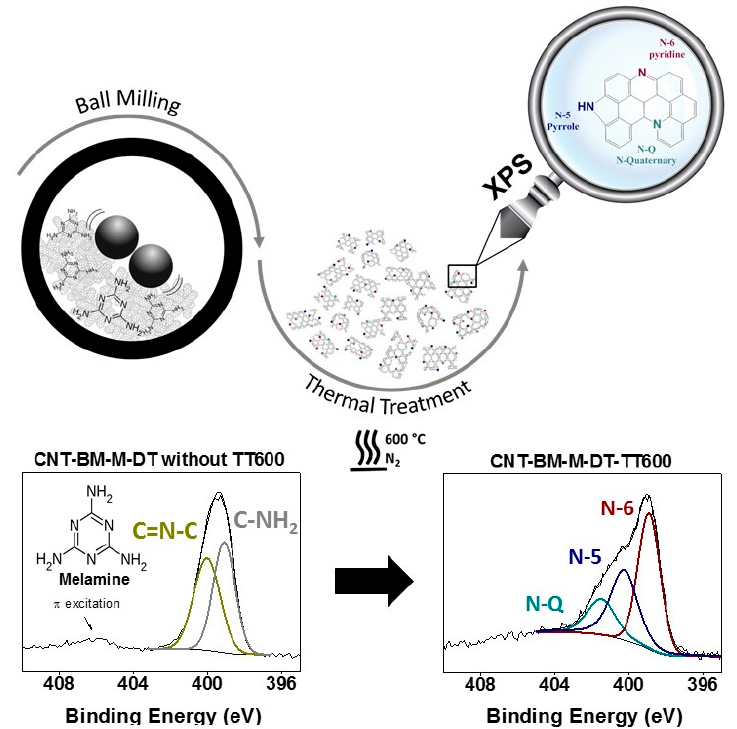
Figure 5. Illustration of the novel easy method to prepare N-doped carbon nanotubes by ball milling, with detailed N1s spectra evolution (adapted from [50,52]).